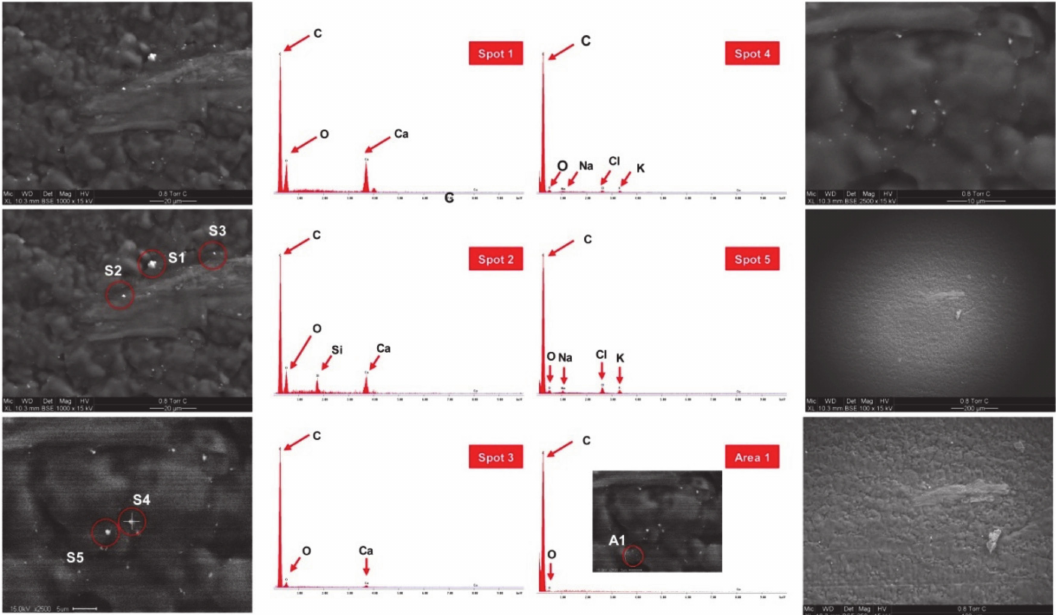
Figure 4. Representative scanning electron microscopy (SEM) / energy–disperse X-ray (EDX) microanalysis of Atp7b – / – liver sections. SEM overviews are shown and selected spots (S1–S5) or areas (A1) of minerals analyzed by EDX are marked by red circles. Identified elements are depicted for each spot or area analyzed. In two di ff erent set of experiments, copper deposits were not detected in Atp7b – / – liver